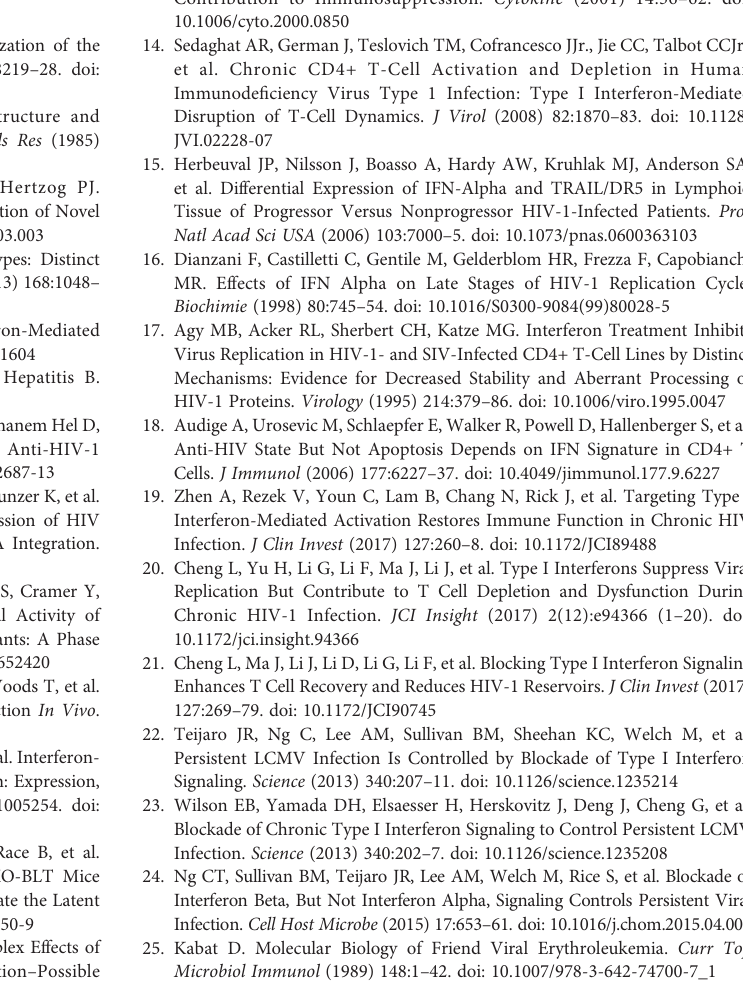
Supplementary Figure 1 | Type I IFN activity on ISRE Luc reporter cells. 3T3 ISRE Luc reporter cells were stimulated with different concentrations of IFN a 11 and IFN b for 4.5h. As control commercially available universal IFN a and IFN b (PBL) were used. Luciferase activity was determined in relative light units (RLU). Three independent experiments were performed and are shown as individual data sets. Supplementary Figure 2 | Serum type I IFN levels at different timepoints post IFN injection. C57BL/6 mice were treated with 8000 units of IFN a 11 or IFN b . At 30, 90, and 240 min post injection, mice were sacri fi ced and type I IFN levels were measured in the serum by IFN a -speci fi c ELISA (A) and ISRE-dependent fi re fl y luciferase activity (B). Statistically signi fi cant differences between the control group (0) and the groups of IFN-treated mice (IFN a 11 or IFN b ) were tested using Kruskal- Wallis one-way and Dunn ’ s multiple comparison and are indicated by *p < 0.05. Supplementary Figure 3 | Neutralizing antibody titers in chronically FV-infected mice. C57BL/6 mice were infected with 20,000 SFFU of FV and additional 100,000 FFU of F-MuLV. Mice were treated daily with 8000 units of IFN a 11 or IFN b from day 40 to 44 post infection. At day 45 post infection, mice were sacri fi ced and serum samples were analyzed for neutralizing antibody titers. At least 8 mice per group from two individual experiments were analyzed and the mean values for each group are indicated by a bar (+SEM). Statistically signi fi cant differences between the control group (FV) and the groups of IFN-treated mice (FV + IFN a 11 or FV + IFN b ) were tested using Kruskal-Wallis one-way and Dunn ’ s multiple comparison and are indicated by *p <